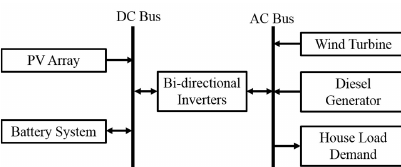
Figure 1. The proposed microgrid system in this study.